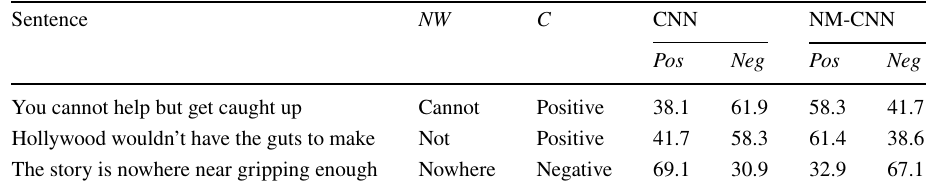
Table 6 Examples about the effect of negative words on MR dataset